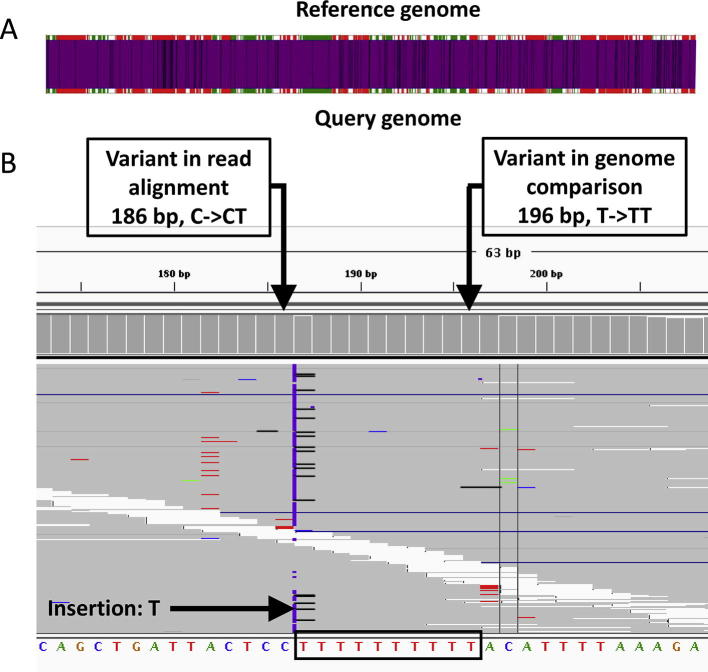
Variant identification by genome comparison A. The pairwise synteny of query and reference genomes. Genes and repeats are colored in red and green, respectively, with gene linkages shown in purple. Variants were identified based on the comparison. B. The variant position difference between read alignment and genome comparison by BLAT. The variant loci were identified by BLAT (right) and the variant position were identified from read alignment (left).